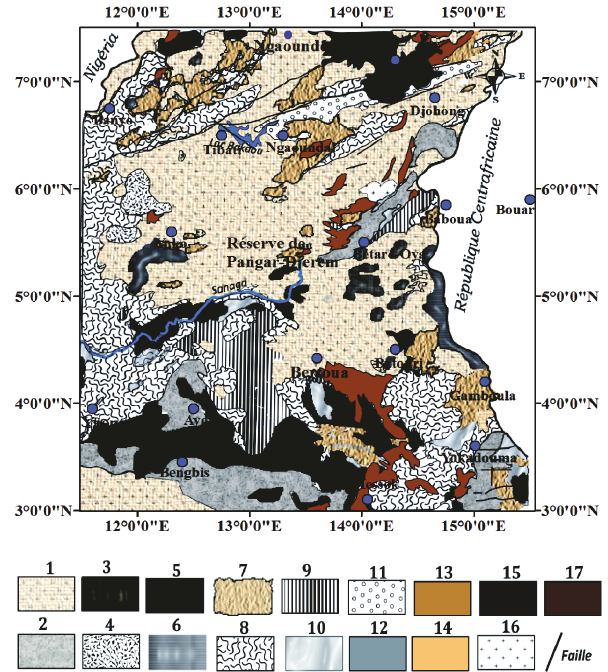
Figure 2: Geological map of the study area ([5] E: 1/1000000): 1, anatexite granite; 2, schist; 3, mica schist; 4, syenite; 5, tray basalt; 6, syn-tectonic granite (Monzonitic, discordant with biotite); 7, anatexite or migmatite with biotite); 8, embrechite gneiss; 9, Upper gneiss (grenatifere with two micas); 10, quartzite (Lom group, Mbalmayo-Bengbis, and Ayos); 11, Sedimentary formation of cretaceous; 12, upper mica schist with chlorite (Poli group); 13, low gneiss (with biotite, amphibole, pyroxene, sillimanite and hypersthene); 14, amphibolite (para- and ortho-: greenstones); 15, pelites; 16, post-tectonic granite (microgranite); 17, calcoalkaline